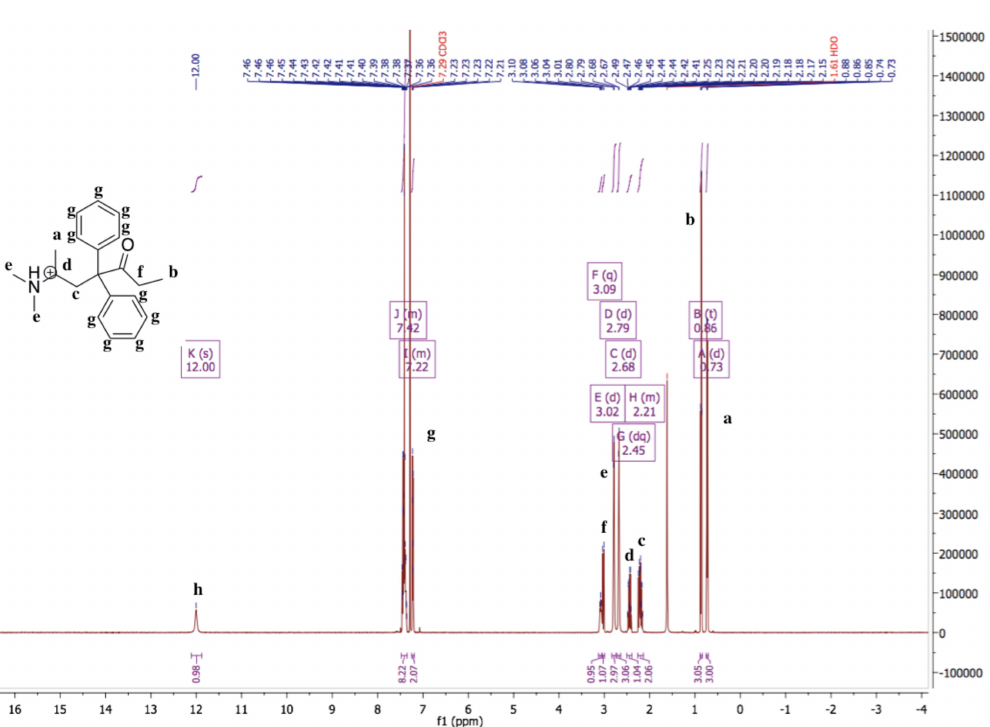
Figure 1. 1 H-NMR spectrum of methadone hydrochloride in chloroform- d . 1 H-NMR (500 MHz, Chloroform- d ) δ 12.00 (s, 1H), 7.48–7.35 (m, 8H), 7.25–7.19 (m, 2H), 3.09 (q, 1H), 3.02 (d, 1H), 2.79 (d, 3H), 2.68 (d, 3H), 2.45 (dq, 1H), 2.26–2.14 (m, 2H), 0.86 (t, 3H), 0.73 (d, 3H). A singlet at 12.00 ppm suggests the protonation of the tertiary